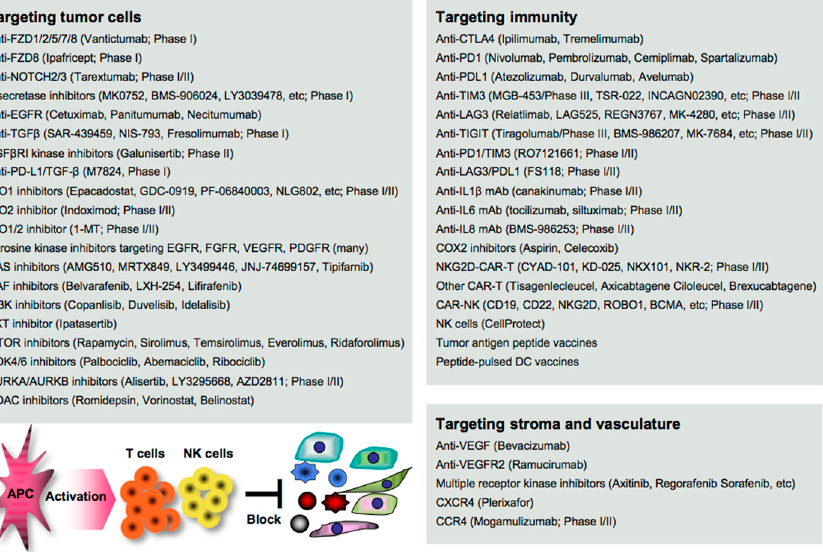
Figure 3. Treatments targeting the oncoimmunological determinants driving cancer metastasis. Numerous agents targeting the cancer metastatic cascade have been pharmaceutically developed, although many clinical evaluations are still underway. The proper combination of certain agents may successfully treat cancer